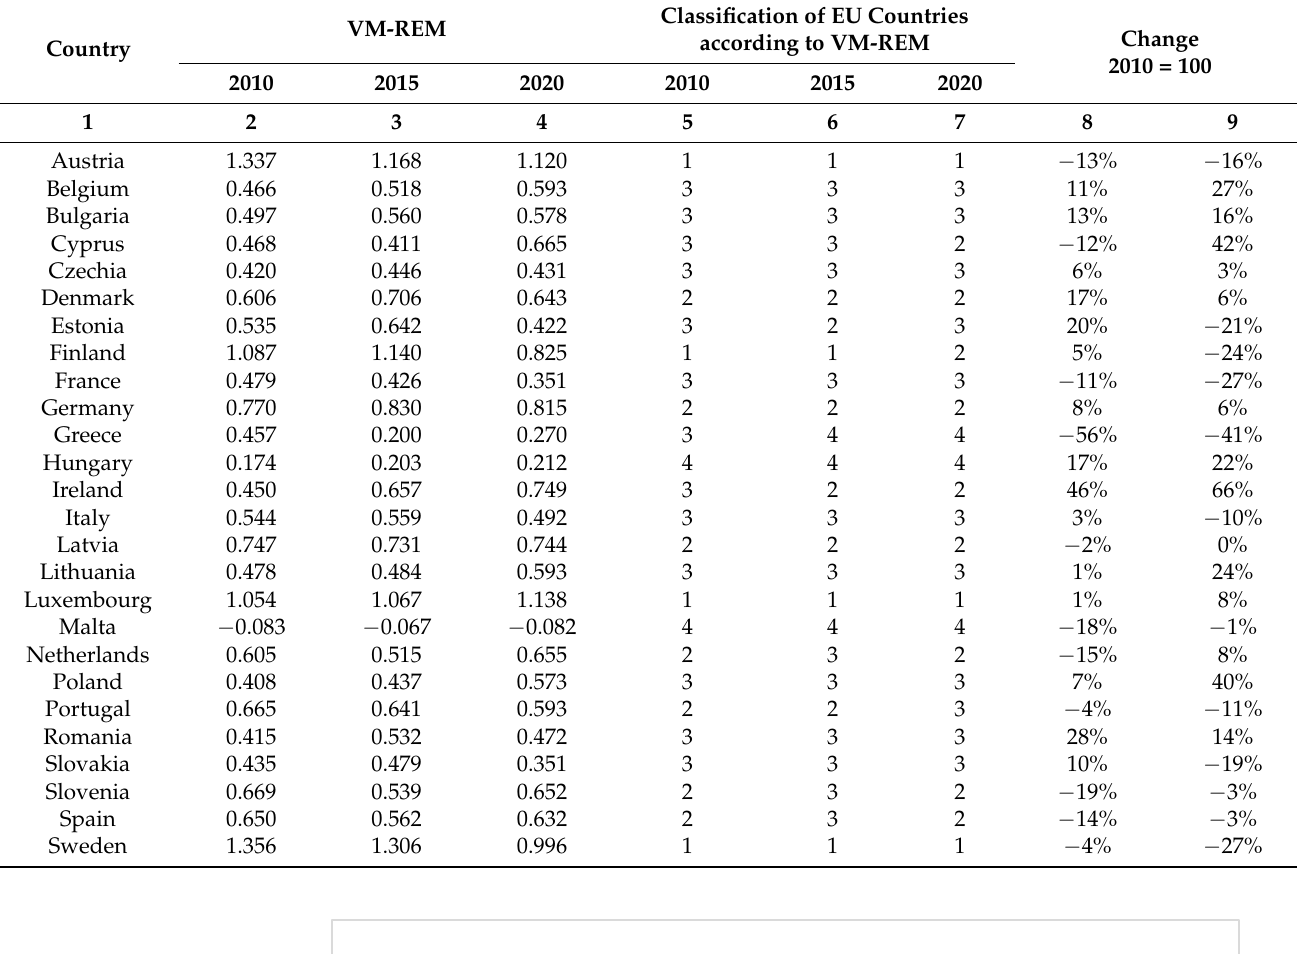
Table 3. Vector metric for energy use in EU countries 2015–2020.